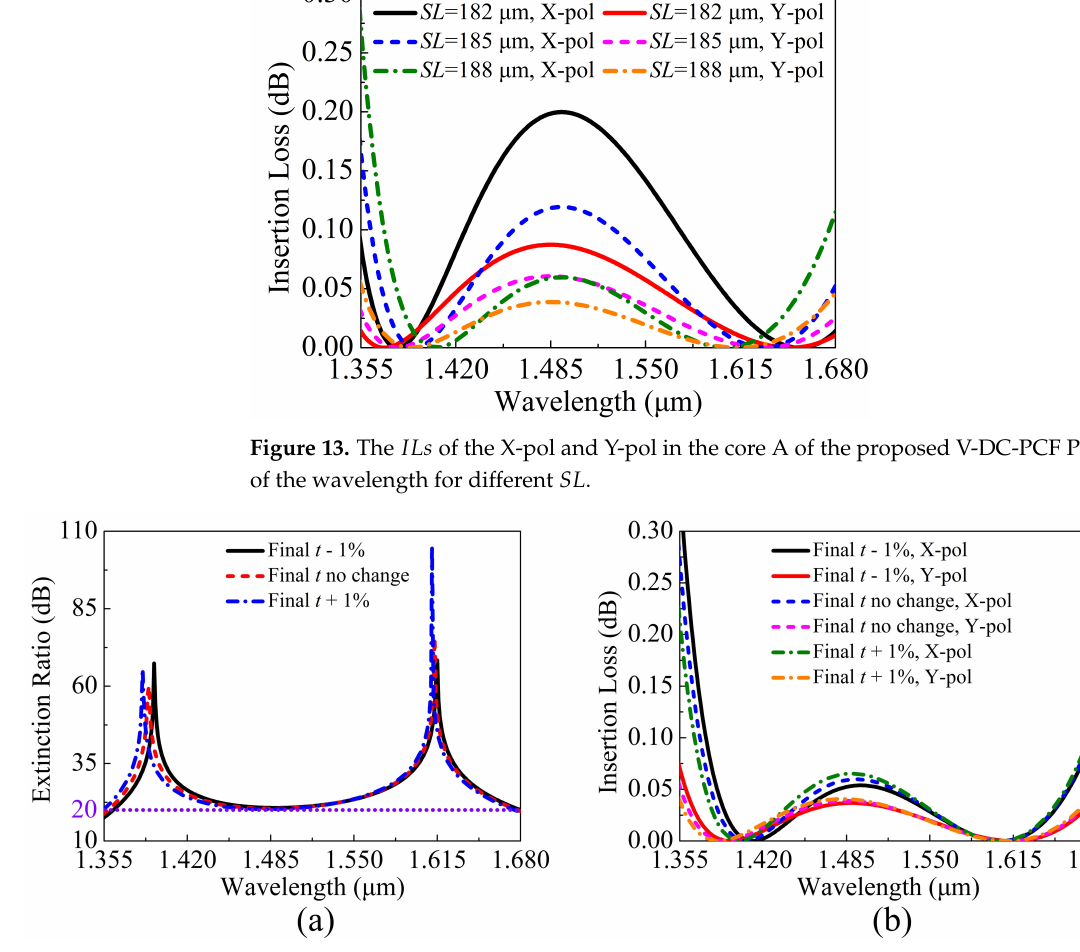
Figure 14. ( a ) ERs in the core A and ( b ) ILs of the X-pol and Y-pol in the core A of the proposed V-DC-PCF PBS as functions of wavelength when t has the distortion of ±